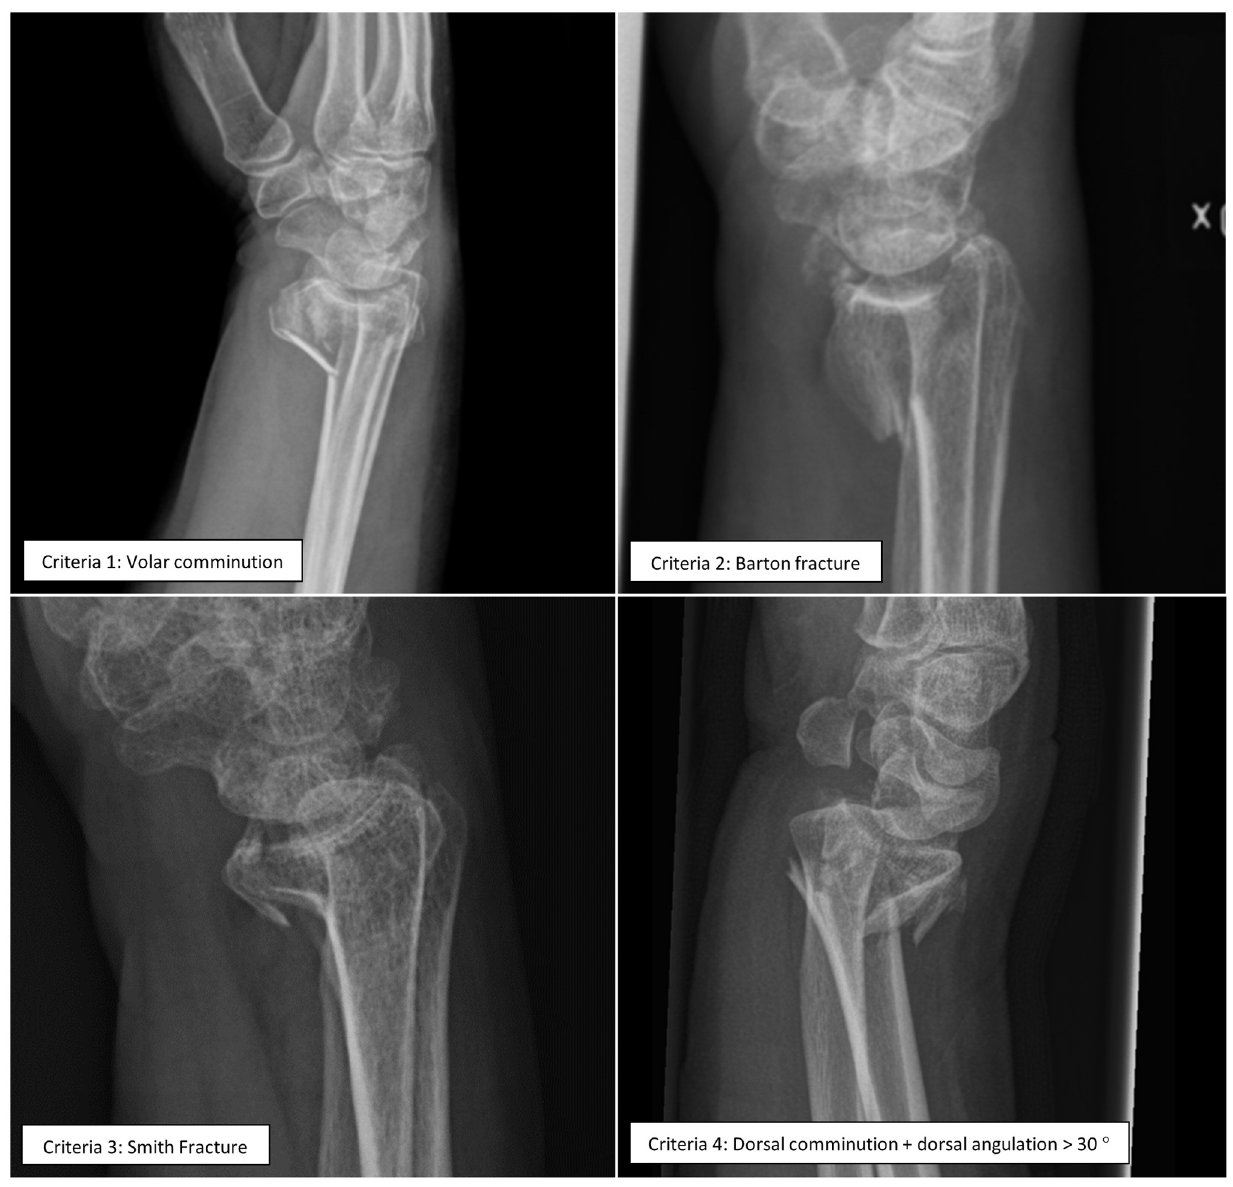
Fig 3. Examples of fractures for each of the defined subgroups suggested in the Swedish national treatment guidelines for distal radius fractures.